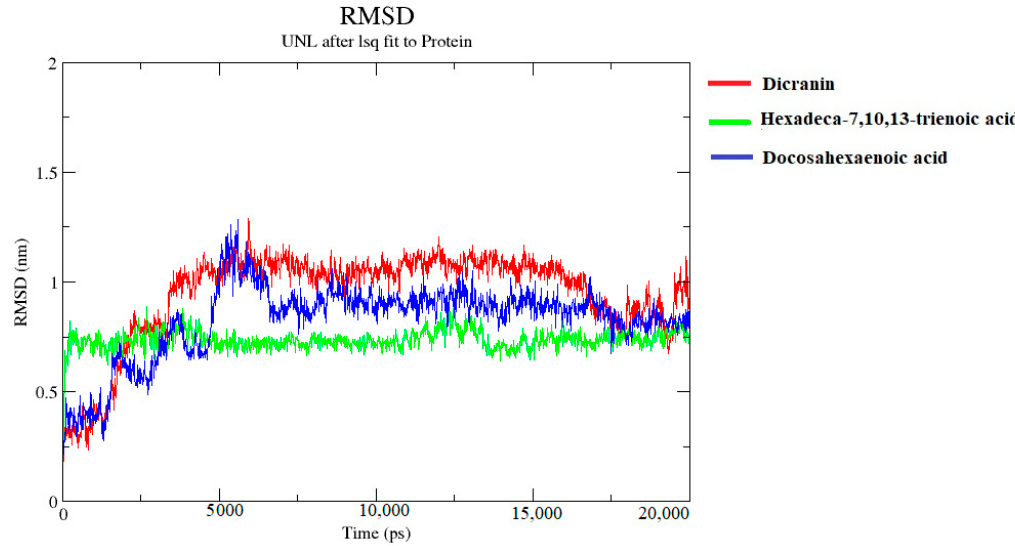
Figure 11. Root mean square deviation (RMSD) plot interactions with dicranin (red), docosahexaenoic acid (blue), and hexadeca-7,10,13-trienoic acid (green) complexes, with protein’s backbone.